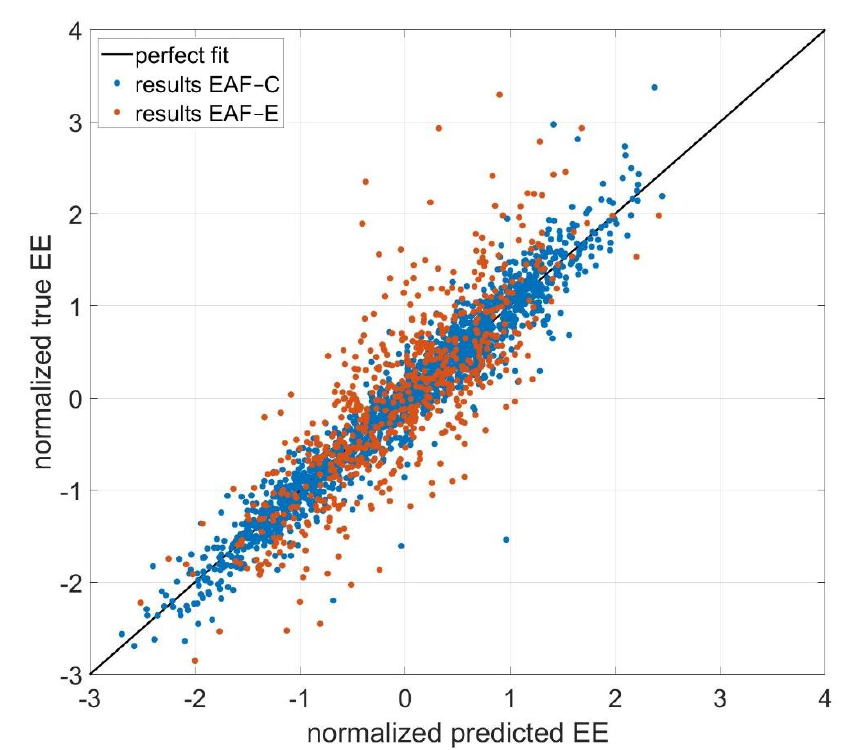
Figure 4. Comparison of normalized estimated electric energy demand of EAF-C and EAF-E. Table 6. Median results for regression on the data available before finishing of the heat.